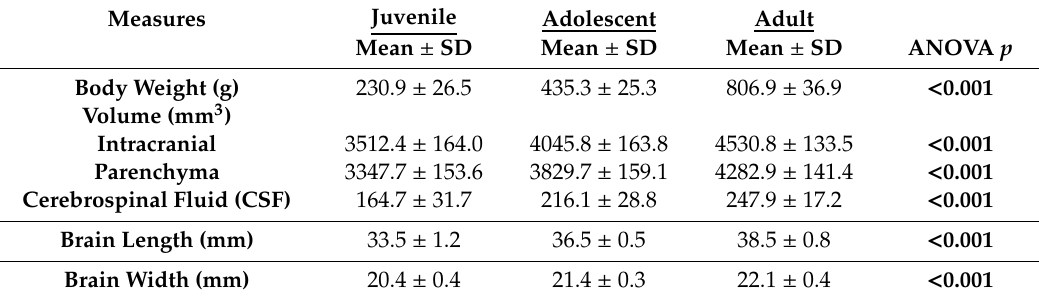
Table 1. Summary of Body Weight and Whole Brain